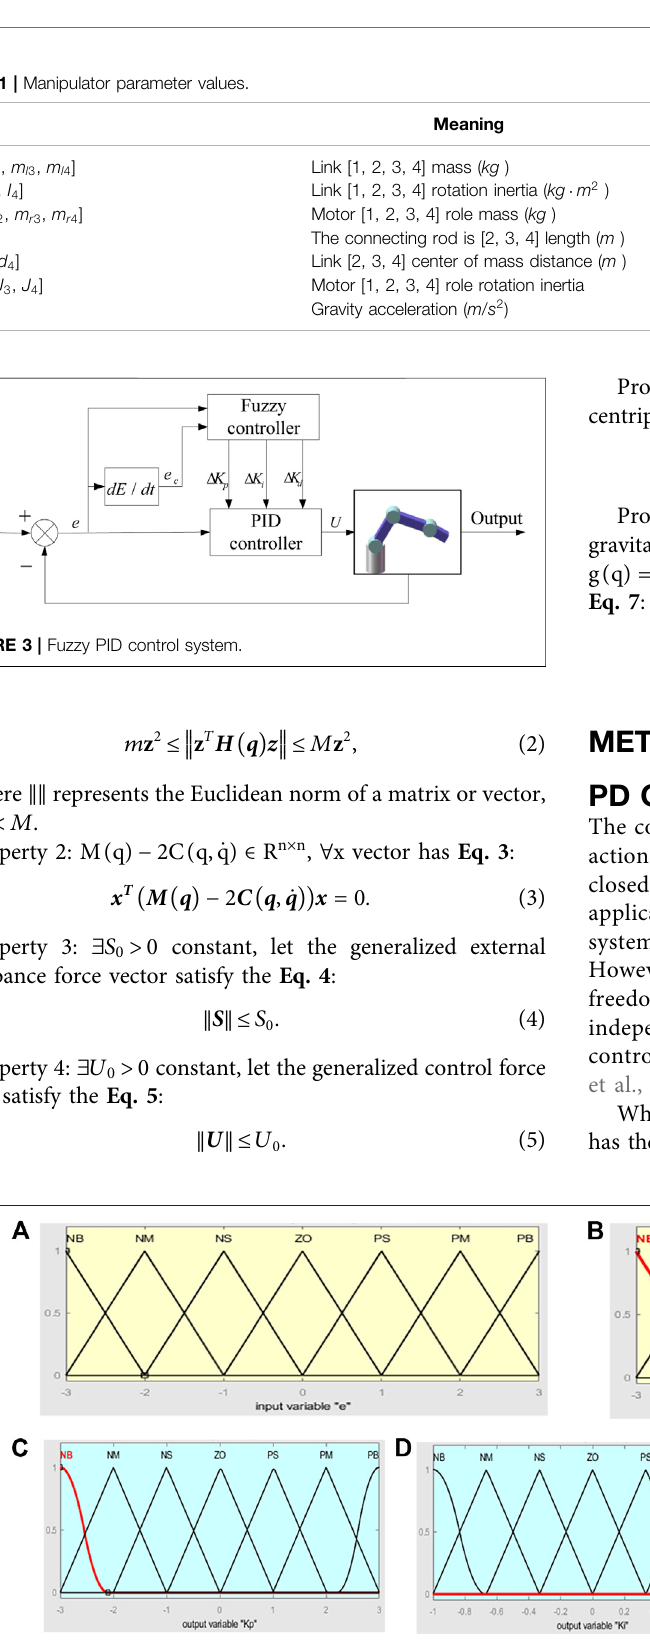
Frontiers in Bioengineering and Biotechnology |